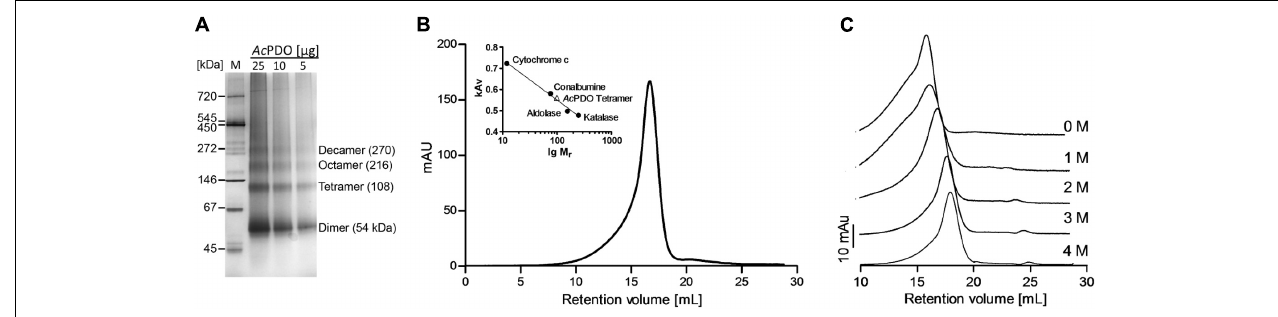
FIGURE 4 | Native Ac PDO and effects of denaturants. (A) Non-denaturing 4–16% polyacrylamide gel with different amounts of Ac PDO; M, Native marker liquid mix for BN/CN (Serva, Heidelberg, Germany); (B) Gel permeation chromatography of freshly prepared Ac PDO (0.5 mg protein) with marker proteins; (C) Gel permeation chromatography of previously frozen Ac PDO (0.1 mg protein) in the presence of different concentrations of guanidinium hydrochloride.